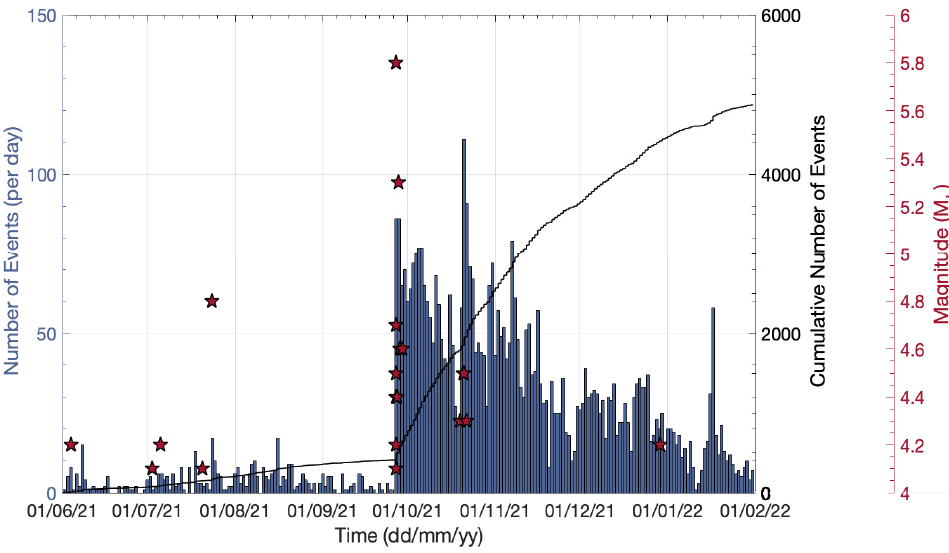
Figure 1. Seismicity rate in terms of events per day (blue vertical bars) and cumulative number of events (solid black line) during June 2021–January 2022 in the area of Arkalohori. The occurrence of events with M L ≥ 4 is marked by red stars (M L magnitude in the red axis to the right).